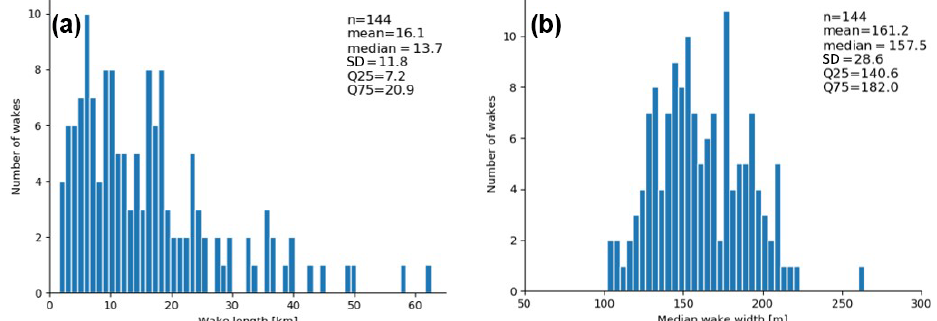
Figure 10. Distribution of observed thermal wake lengths (a) and widths (b) , in the shipping lane area indicated in Fig. 1c. The observations are from satellite scenes with visible thermal wakes and < 23% cloud cover, for the period April 2013 to December 2018 ( n = 144).